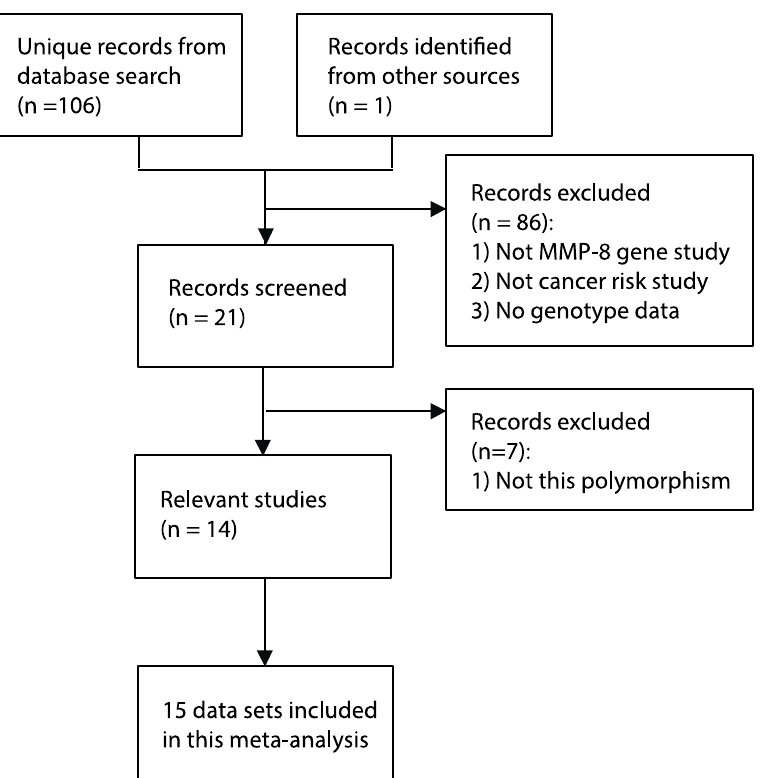
Figure 1. Systematic review flowchart of this meta-analysis.